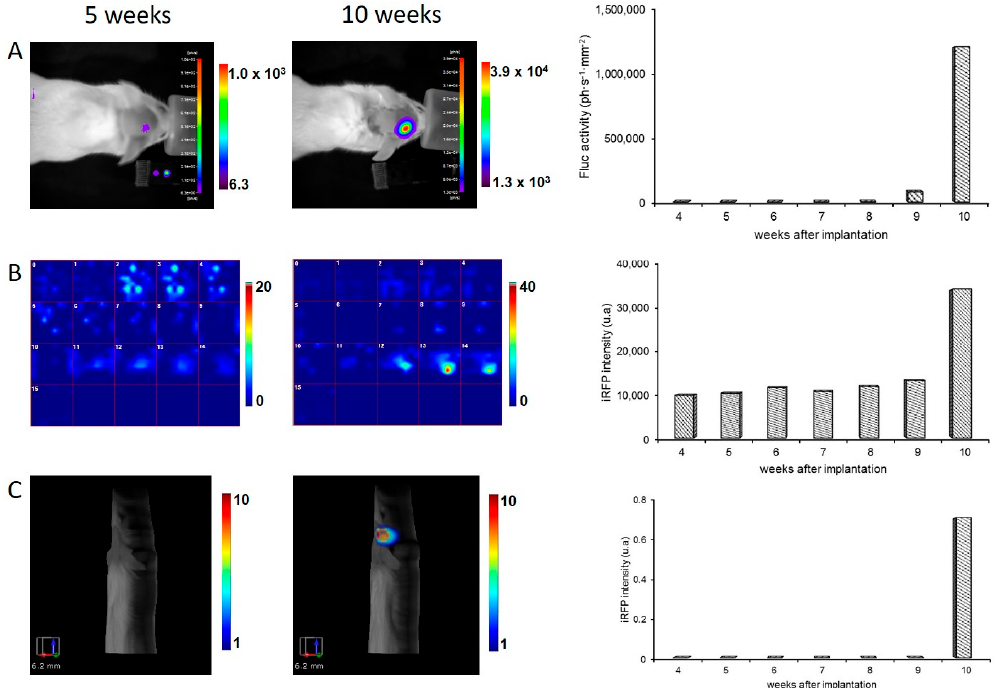
Figure 3. In vivo detection of Fluc activity and iRFP fluorescence by brain tumors U87-iRFP+-Fluc+. ( A ) BLI of a mouse at 5 weeks and at 10 weeks after cell injection. The graph represents the bioluminescence quantification of the mouse; ( B ) detection of the iRFP-fluorescent signal by fluorescence diffuse optical tomography (fDOT) of the same mouse at 5 and 10 weeks after cell injection. Z cross sections (1 mm thickness) are presented in the same color scale from z = 0 (ventral) to z = 15 (dorsal). Quantification of the fluorescence signal recovered from fDOT imaging at different times are plotted on the graph; ( C ) 3D representation of the iRFP-fluorescent signal by FMT ® of a mouse at 5 and 10 weeks after cell injection. Quantification of the fluorescence signal recovered from FMT ® imaging at different times are plotted on the graph.